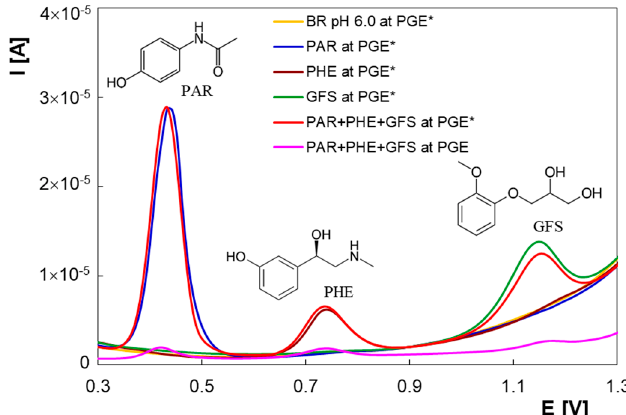
Figure 1. Differential pulse voltammograms of 2.00 × 10 − 5 M PAR, 2.00 × 10 − 5 M PHE, 2.00 × 10 − 5 M GFS and a mixture of PAR, PHE and GFS (2.00 × 10 − 5 M each) at PGE and PGE* in BR buffer pH 6.00.